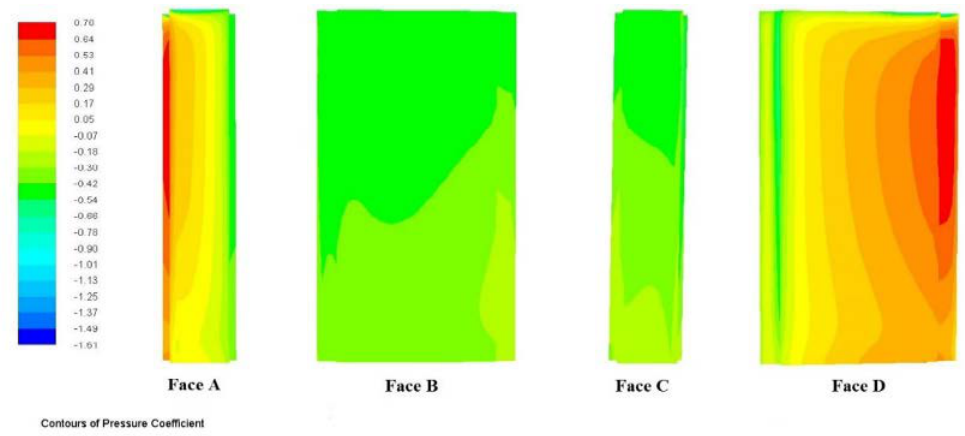
Fig. 5(b). Contours of pressure coefficient at 45° Wind incidence angle.